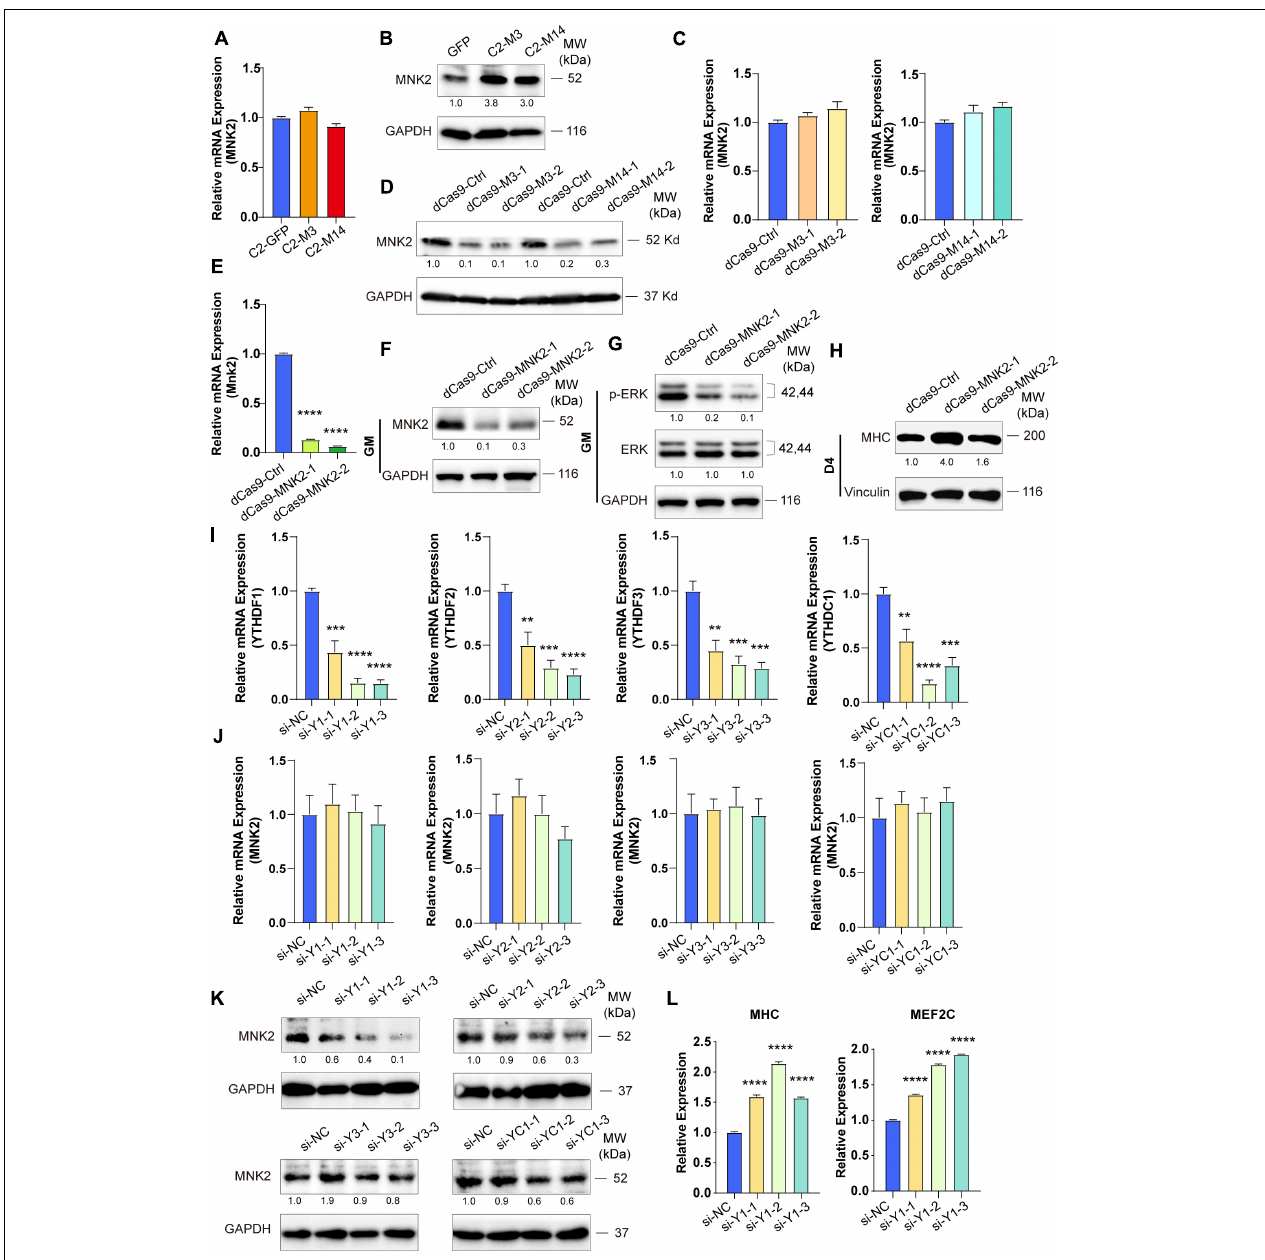
FIGURE 5 | MNK2 is a downstream target of METTL3/14 via YTHDF1-dependent manner. METTL3/14 doesn’t affect the RNA expression level of MNK2. Real-time PCR analysis of the expression of MNK2 in the indicated METTL3- or METTL14- overexpressing (A) or knockdown (C) C2C12 cells. METTL3/14 promotes the protein expression of MNK2. MNK2 was determined by western blot in indicated METTL3- or METTL14- overexpressing (B) or knockdown (D) C2C12 cells. (E) Real-time PCR analysis of the expression of MNK2 in the MNK2 knockdown C2C12 stable cell lines. (F) MNK2 was determined by western blot in the MNK2 knockdown C2C12 stable cell lines in GM condition. (G) MNK2 affects protein expression of ERK signaling. This examination were carried out in GM condition and Vinculin as internal control. (H) MNK2 accelerates the protein expression of myogenic marker MHC. This examination were carried out in D4 condition and Vinculin as internal control. (I) Real-time PCR assays of each reader in the indicated YTH siRNA or siNC treatment. (J) si-YTH doesn’t affect the RNA expression level of MNK2. (K) The effects of si-YTH on the protein expression level of MNK2. (L) si-YTHDF1 accelerates RNA expression of MHC and MEF2C. Quantitative data was represented as Mean ± SD. ** p < 0.01, *** p < 0.001, **** p <